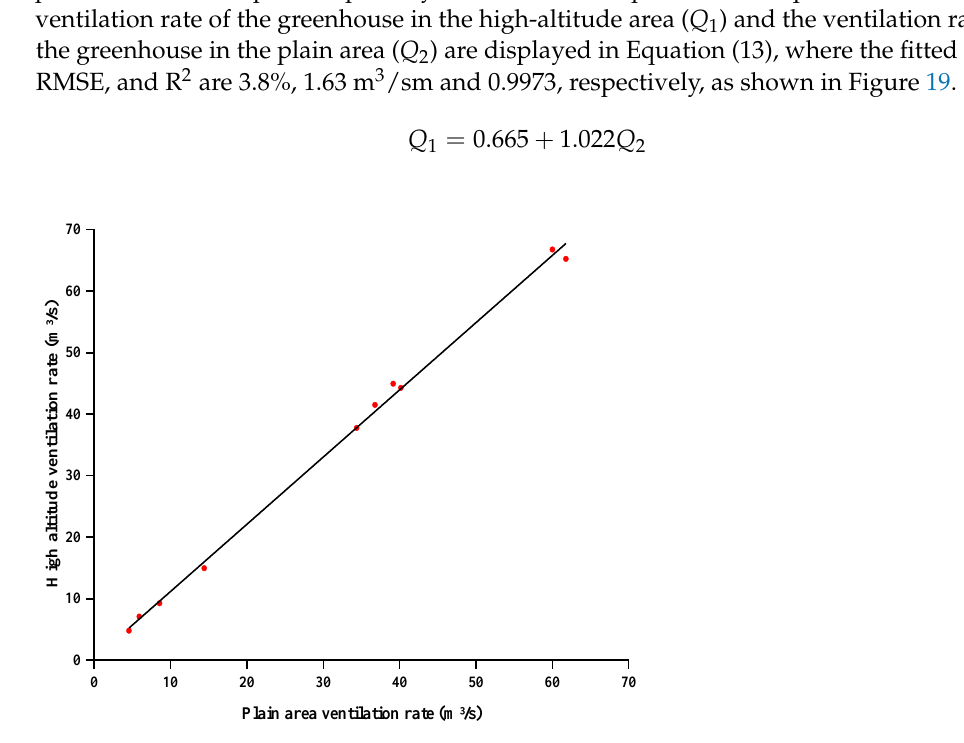
Figure 19. Fitted ventilation rate in the high-altitude area with the plain area ventilation rate. Based on Equation (9), the multivariate nonlinear fit of the ventilation rate in the plain area results in f u = 0.589 and 𝑓 ΔΘ = 0.01 m s −1 K −1 /2 . The ARE between the sample value and the fitted value is 4.55%, as shown in Figure 20.